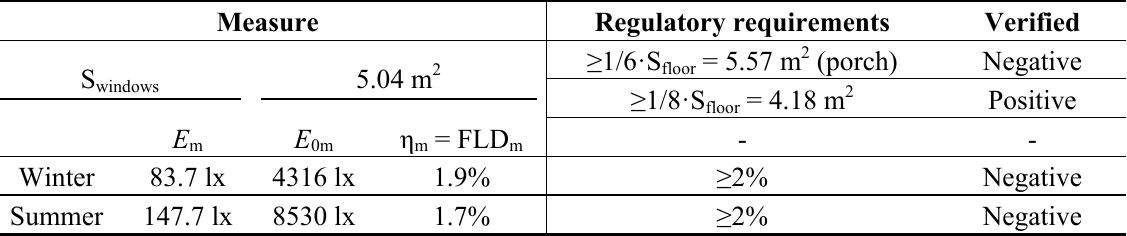
Table 4. Indoor daylight in a monitored room in Building